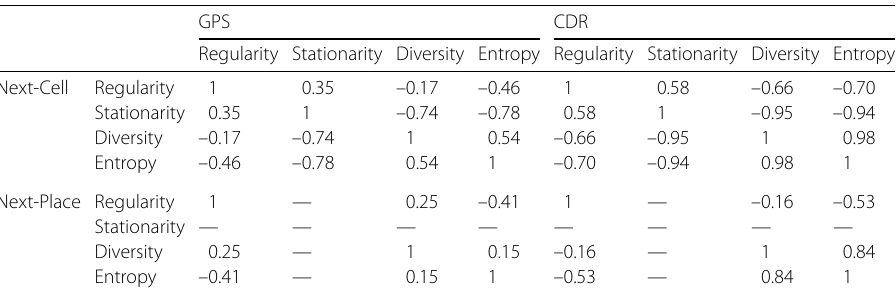
Table 3 Pairwise Spearman’s correlation coefficient between each proxy metric as well as between each metric and the entropy, computed for the routine component each user’s mobility trace GPS CDR Regularity Stationarity Diversity Entropy Regularity Stationarity Diversity Entropy